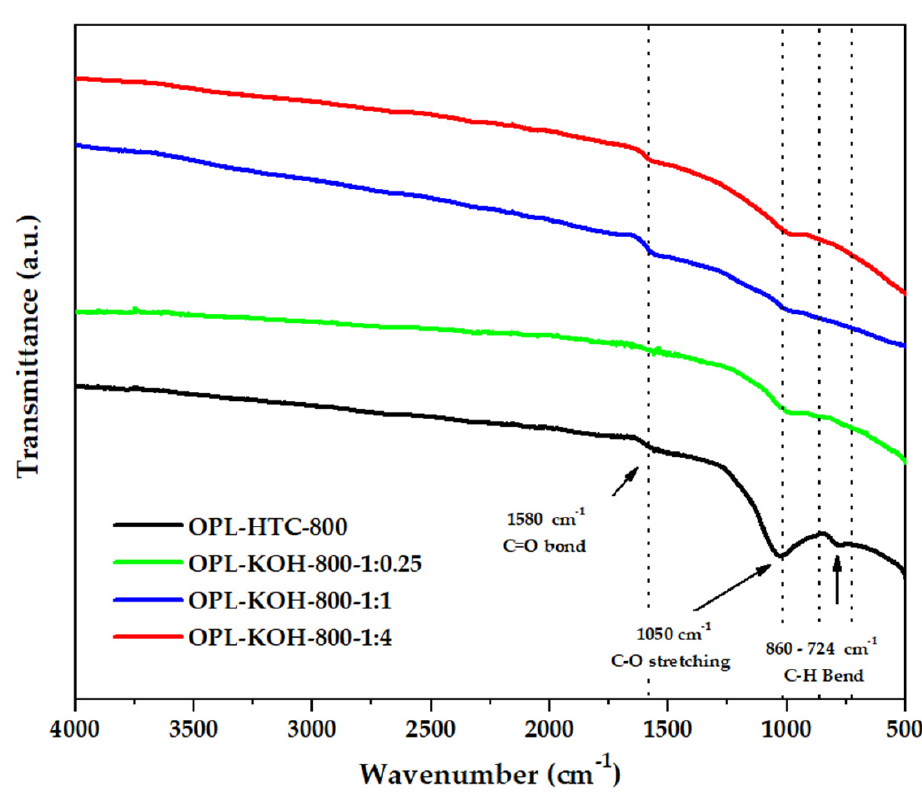
Figure 6. FTIR spectra of OPL − 800, OPL − KOH − 800 − 1:0.25, OPL − KOH − 800 − 1:1, and OPL − KOH − 800 − 1:4.